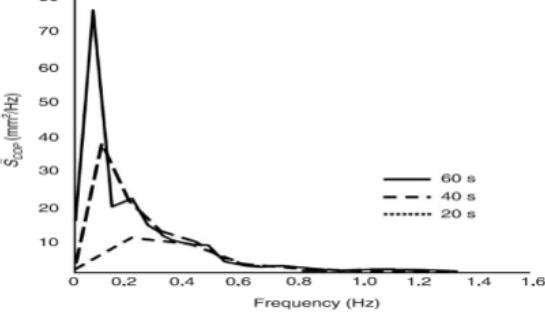
Figure 1. Frequency spectrum of a CoP signal [7].